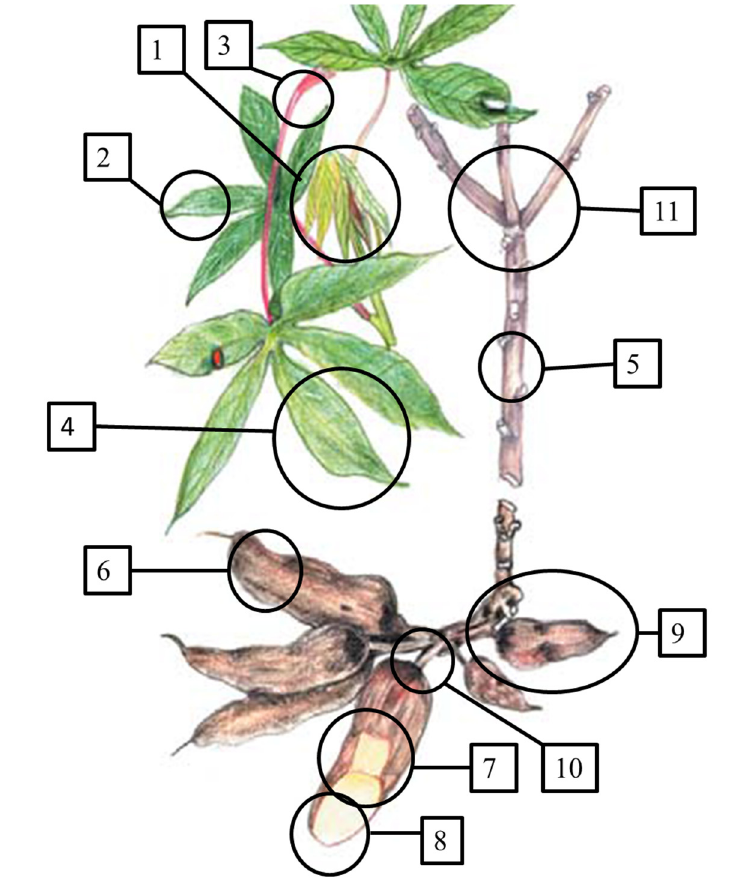
Figure 1. Morphological features used to describe manioc morphotypes. The illustration is a modification (with permission of the Sinchi Institute) of one of the drawings elaborated by Luis Angel Ramos del Águila describing a Tikuna manioc landrace